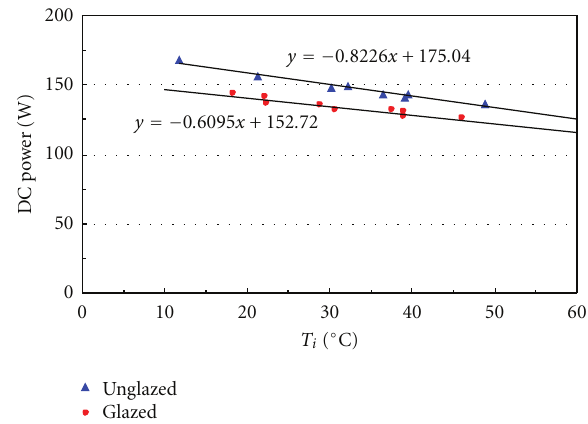
Figure 8: Electrical power of the glazed PVT collector as a function of solar radiation and fluid temperature.